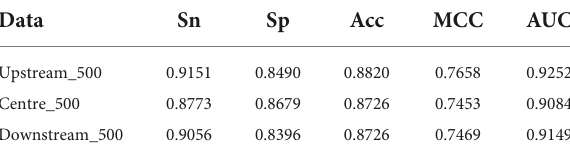
TABLE 2 Predictive performance of amino acid residues from different positions.